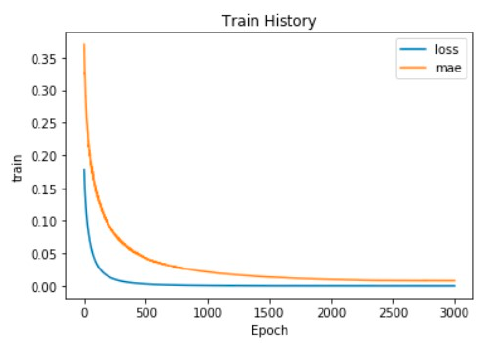
Figure 14. The training process of RNN. J. Mar. Sci. Eng. 2020 , 8 , x